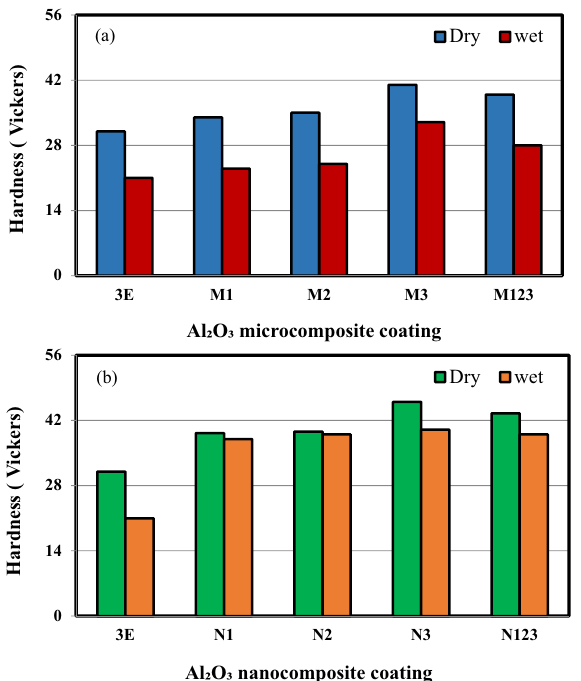
Figure 2. The hardness of multilayers epoxy coating to steel substrate filled with ( a ) Al 2 O 3 microparticles ( b ) Al